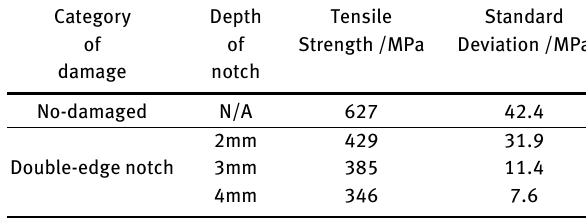
Table 3: Tensile result of 3238A/CF8652